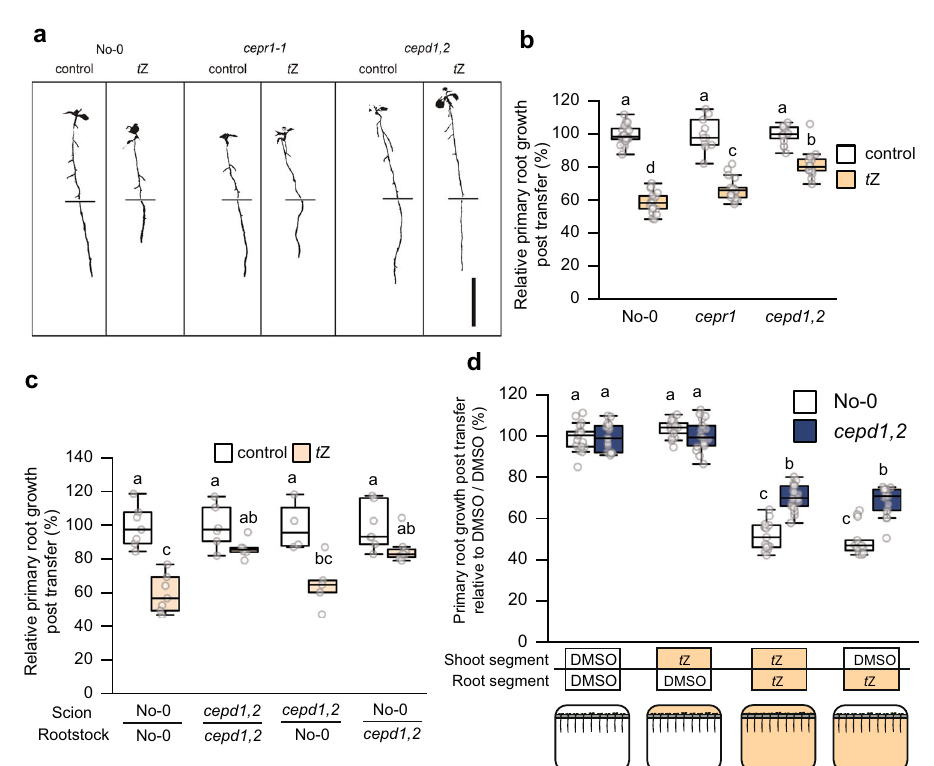
Fig. 5 | Cytokinin signalling through root CEPDs inhibits primary root growth. a Representativeimagesand( b )relativeprimaryrootgrowthforNo-0, cepr1-1 ,and the cepd1,2 double mutant seedlings 3 days after transfer to medium with or without t Z (10nM) (n=11 – 24 plants). Horizontal bars in ( a ) indicate the length of the primary root on the day of transfer (i.e. 6 days growth). Root growth post transfer expressed as a percentage of seedlings grown on solvent control (DMSO) for each respective genotype. c t Z sensitivity of reciprocal hypocotyl grafts between No-0 and cepd1,2 . Primary root growth 3 days post transfer to t Z (5nM) expressed as a percentage of seedlings transferred to DMSO (control) for each respective graft combination ( n =4 – 8 plants). d Relative primary root growth for No-0 and cepd1,2 seedlings 3 days post transfer to segmented plates for t Z treat- ment of roots and/or shoots. See lower panel for diagrammatic representation of